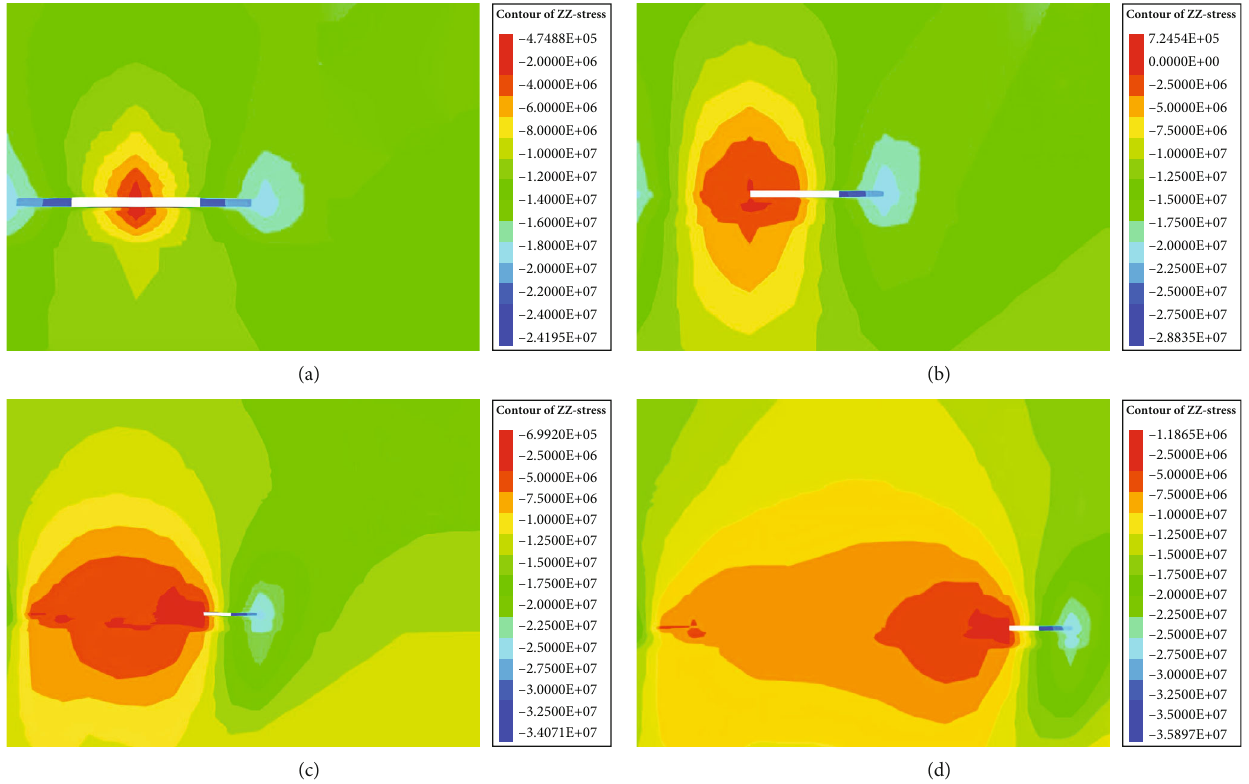
Figure 5: Dynamic evolution of mining-induced stress during the single 8-1 coal seam mining at various advance distances: (a) 24m, (b) 56m, (c) 120 m, and (d)